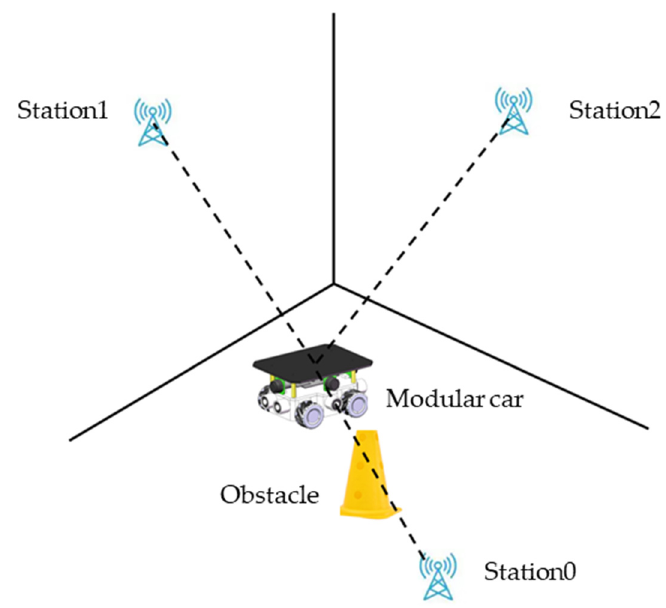
Figure 5. UWB positioning system.